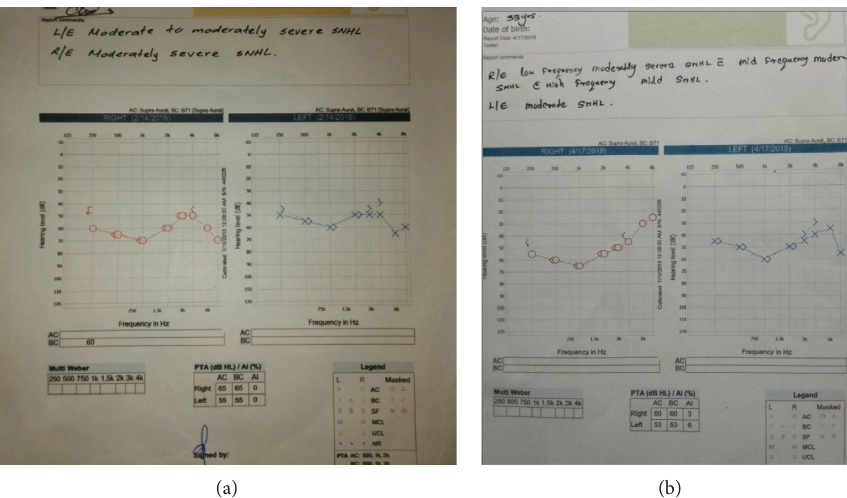
Figure 2: Pure tone audiometry showing bilateral moderately severe sensoneural deafness at presentation (a) and some improvement after one month (b).